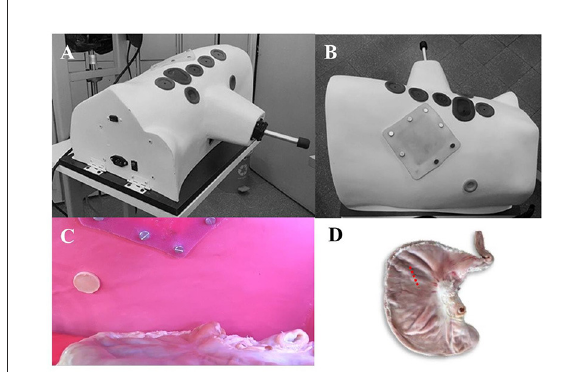
FIGURE1 Photographs of the simulation model for performing pure laparoscopic gastropexy in canines (CALMA Veterinary Lap-trainer Simulator – CVLTS) (A,B) external appearance of the simulator, showing the arrangement of the linear ports and the simulated silicone abdominal wall. (A) Ventro-lateral view of the simulator showing the arrangement of the ports. For the TLG, 1 (subxiphoid) and 4 (paraumbilical) are used. (B) Dorsal view of the simulator where the silicone patch that mimics the abdominal wall can be seen where the percutaneous needle is passed and the intracorporeal suture is performed internally. (C) Internal view of the simulator. The stomach is shown ventrally in position to be anchored. (D) Position of the stomach during